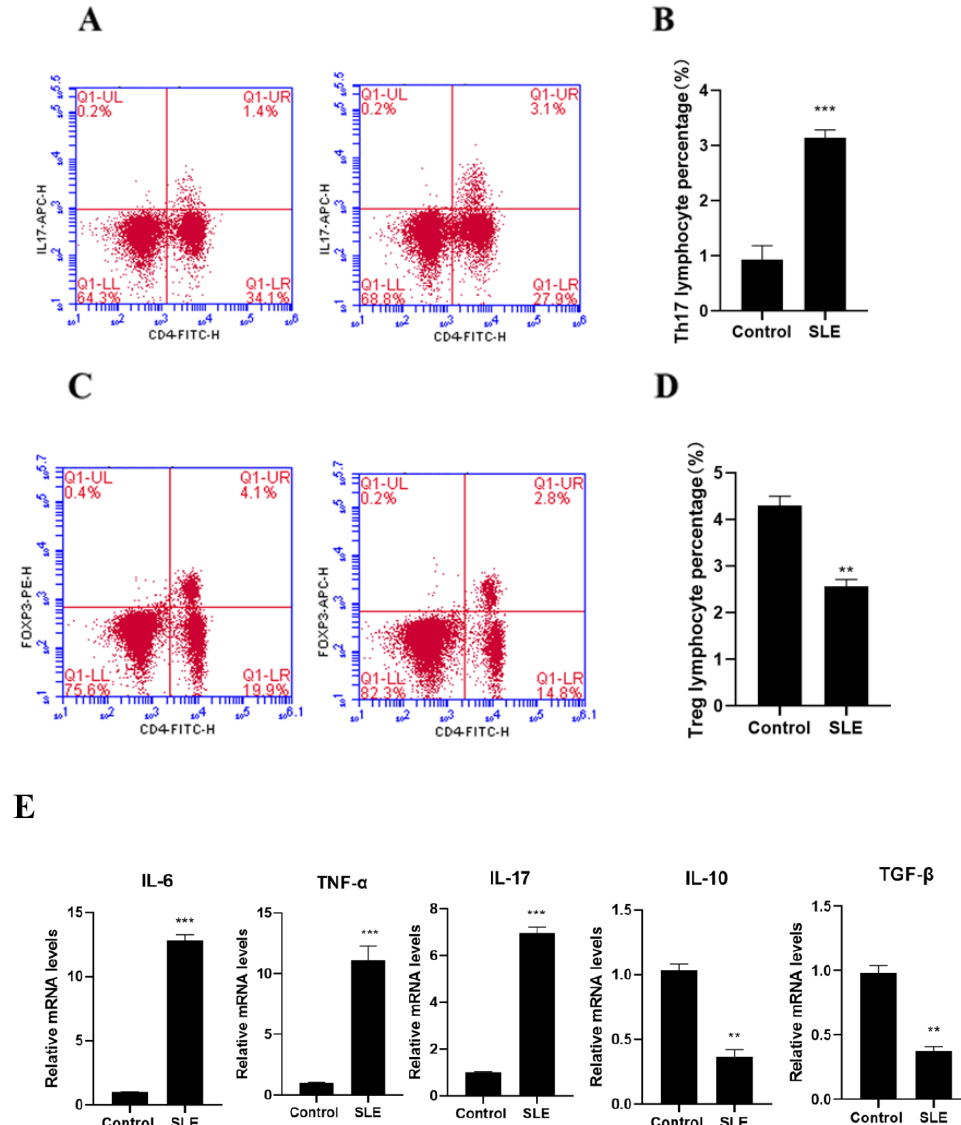
Figure 2. Imbalance of Th17/Treg production in SLE patients. ( A ) Flow analysis of CD4 + IL-17 + Th17 cells, ( B ) percentage of CD4 + IL-17 + Th17 cells, ( C ) flow analysis of CD4 + Foxp3 + Treg cells, ( D ) CD4 + Foxp3 + Treg percentage of cells, ( E ) PBMC production of cytokines IL-6, TNF- α , IL-17, IL-10, and TGF- β, compared to control .** p < 0.01,*** p < 0.001.